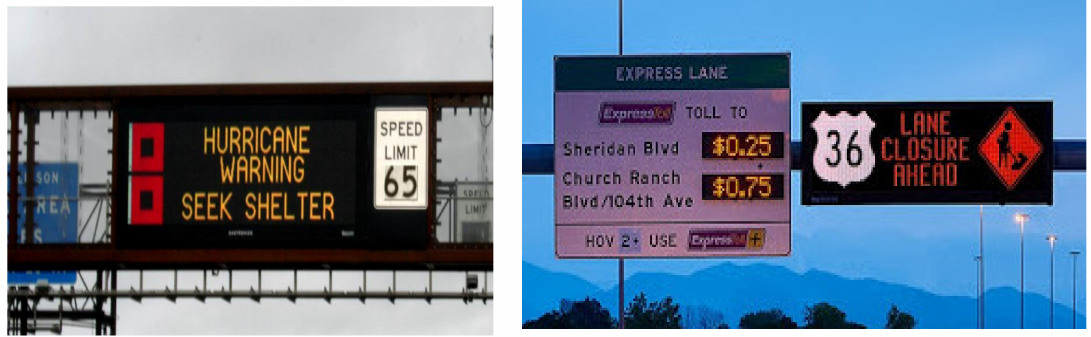
Figure 13. DMS’s in New Jersey (Daktronics Transportation) and Colorado